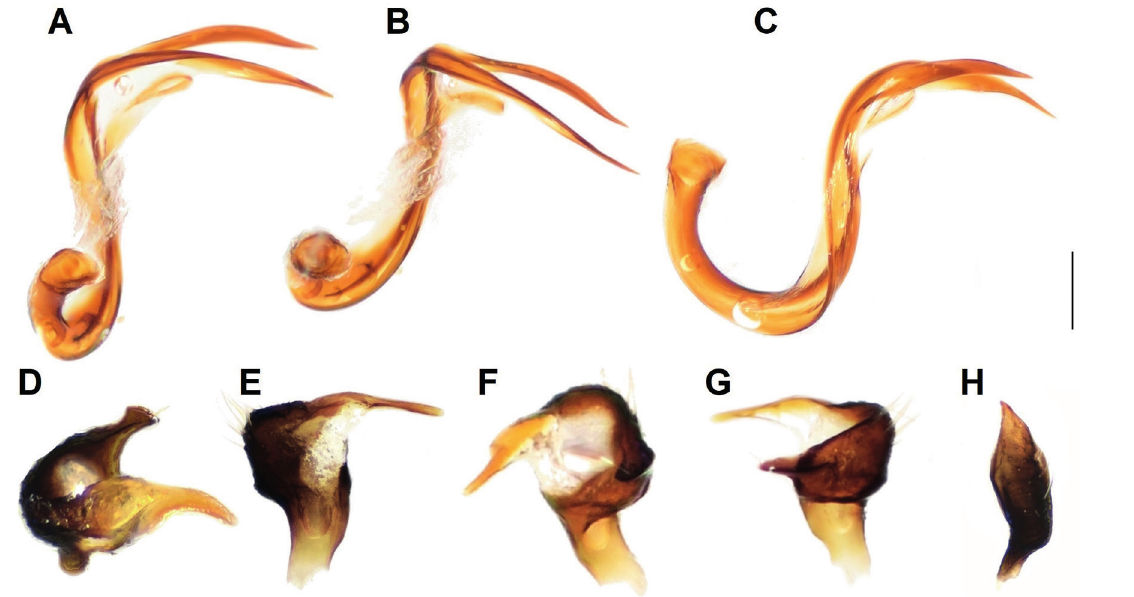
Fig. 3. Plagiognathus ozgurkocaki sp. nov., ♂, paratype (LEMT). A – C . Vesica from different perspectives. D–G . Left paramere from different perspectives. H . Right paramere. Scale bar = 0.1